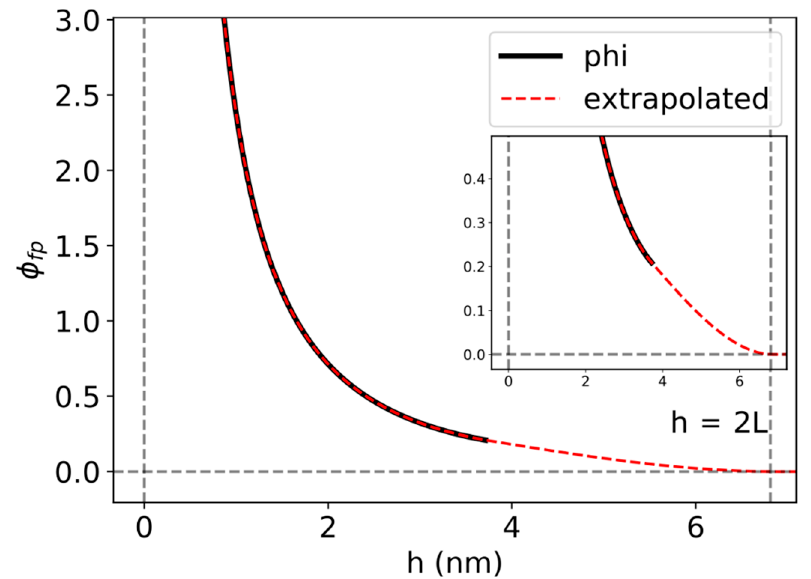
Figure A2. Extrapolation of Φ fp for h ≥ 2 L. Inset shows a zoomed in vertical axis.